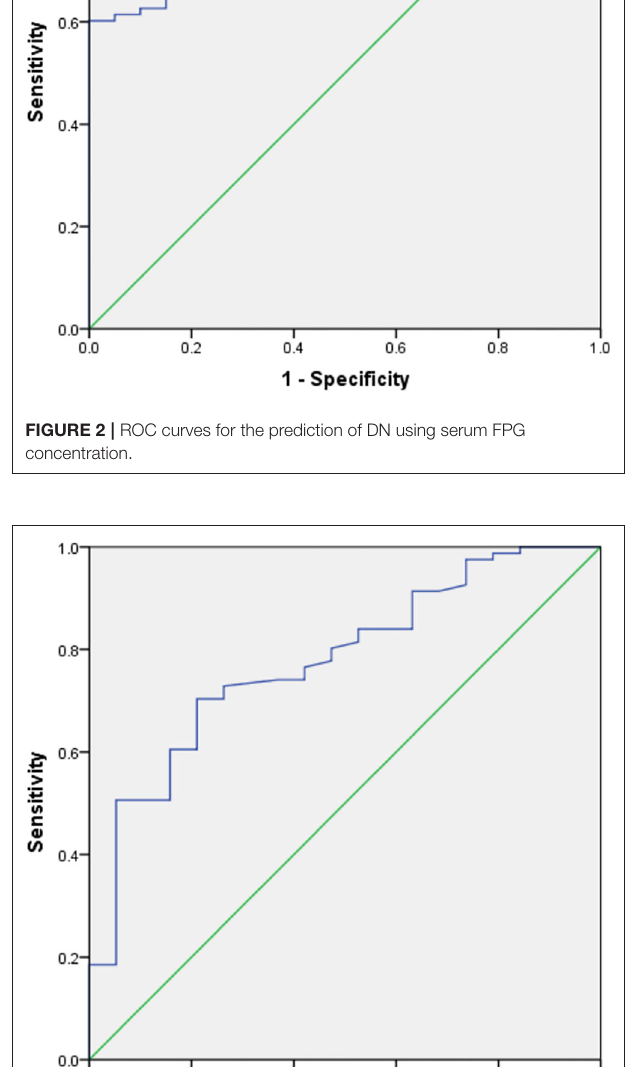
FIGURE 3 | ROC curves for the prediction of DN using serum IL-10 concentration.